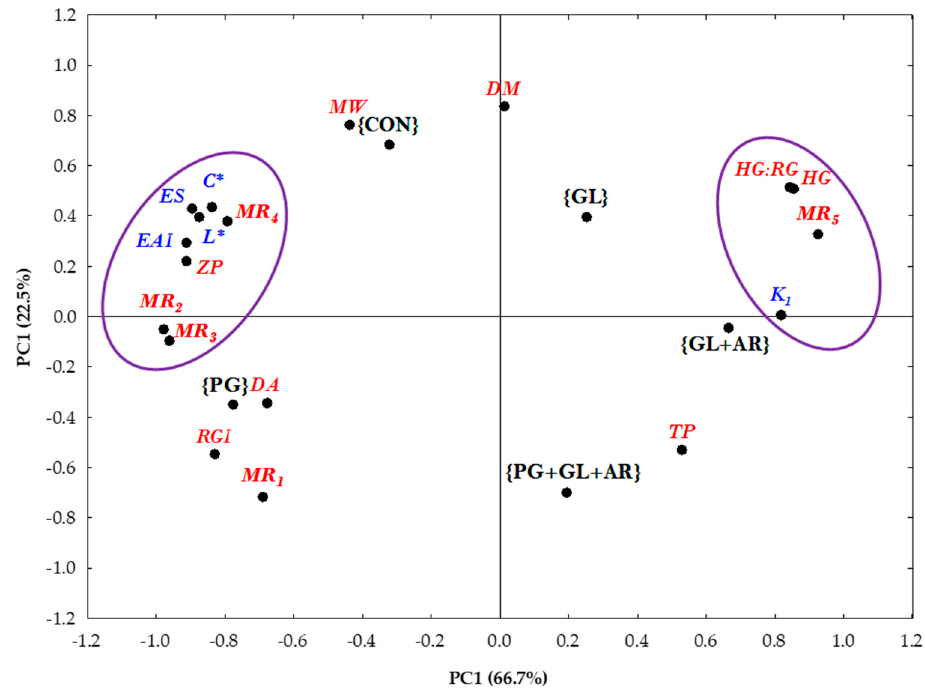
Figure 5. Principal component analysis (PCA) plot of OKP following enzymatic treatments (black- colored components). Red-colored and italicized components are emulsifying parameters, and blue-colored components are molar ratios. Variables within the purple circles are closely related.